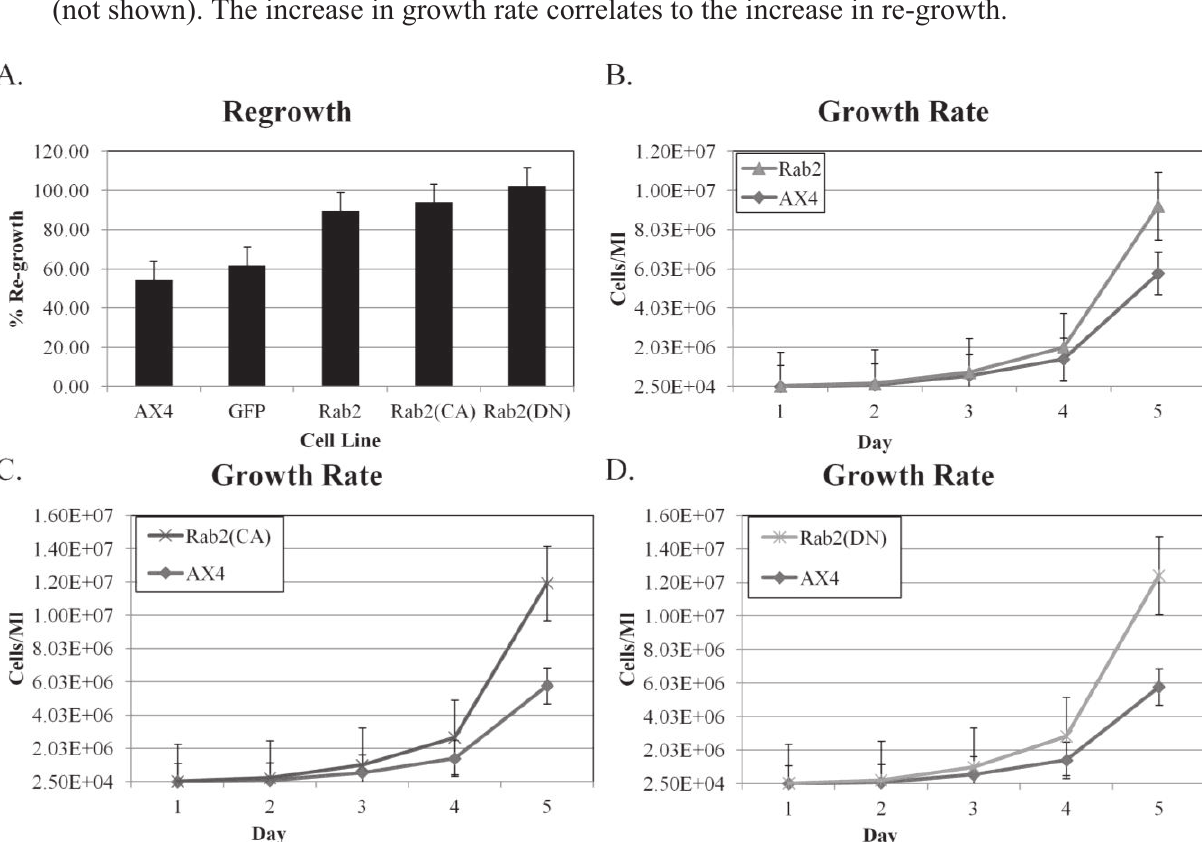
the fastest growth rate at almost 10X that of the AX4 cells and their ability to re-grow after treatment with DIF-1 reached above 100% indicating that they not only completely re-grew after treatment but they had begun to proliferate. Figure 8. DdRab2 over-expressing, DdRab2(CA), and DdRab2(DN) cells have increased re-growth and growth rates compared to controls. ( A ) Percentage of re-growth of the mutant cells after 30 h of treatment with DIF followed by 72 h incubation with HL5. The ratio of the number of cells re-growing in the DIF chamber to the number of cells in the control chamber was calculated. Data are the average of three indepent experiments with a p -value > 0.05. Rab2 over-expressing, Rab2(CA), and Rab2(DN) cell lines had a significantly increased level of re-growth compared to the AX4 and pDneo2a-GFP cell lines. ( B – D ) Growth rate of Rab2 over-expressing, Rab2(CA), and Rab2(DN) cell lines. Cells were incubated in HL5 medium. At the same time each day cells were counted. Data are the average of three independent experiments with a p -value > 0.05. All cell lines have a significant increase in growth rate compared to the AX4 and pDneo2a-GFP (not shown). The increase in growth rate correlates to the increase in